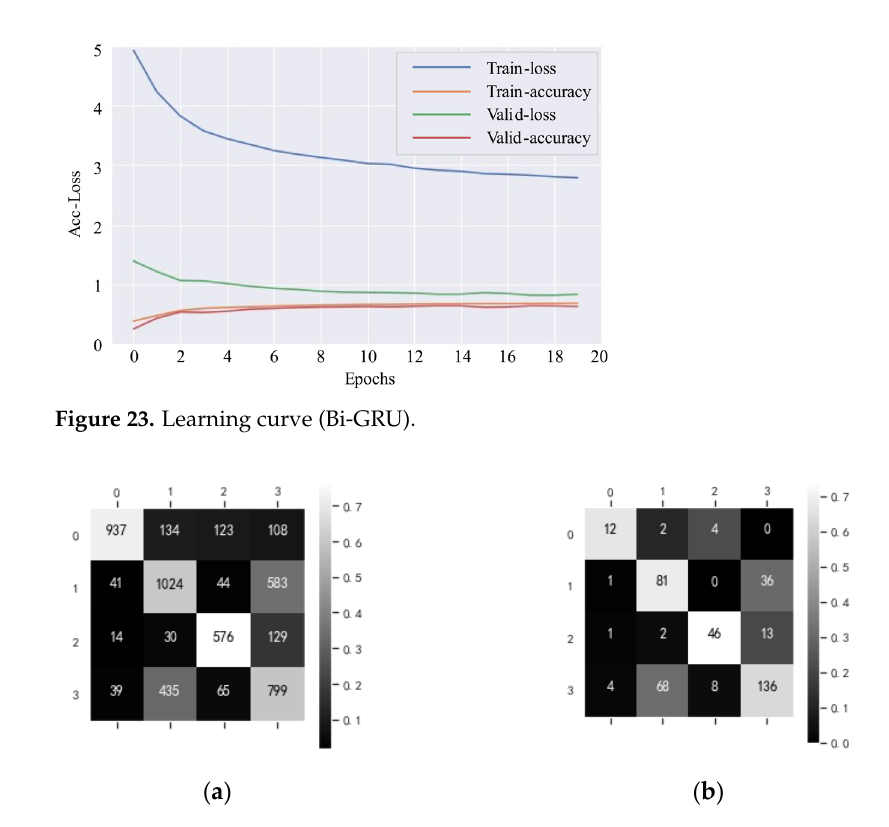
Figure 24. ( a ) Confusion matrix of sub-trajectories (Bi-GRU); ( b ) Confusion matrix of ships (Bi-GRU).